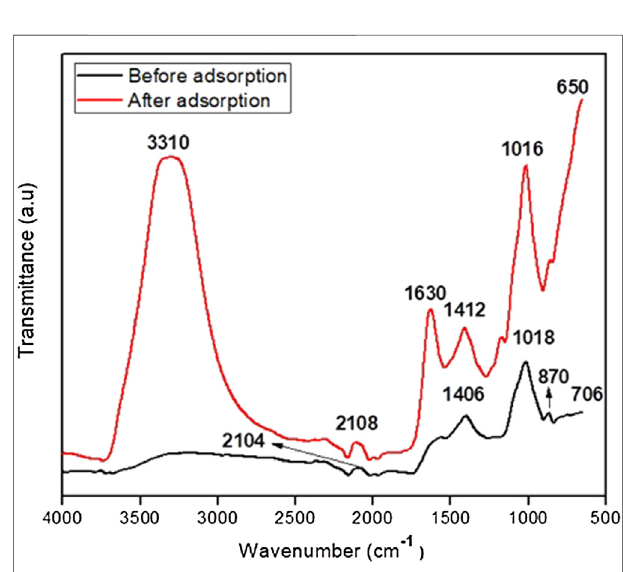
FIGURE 4 | FTIR spectra of the poultry manure-derived biochar before and after adsorption.